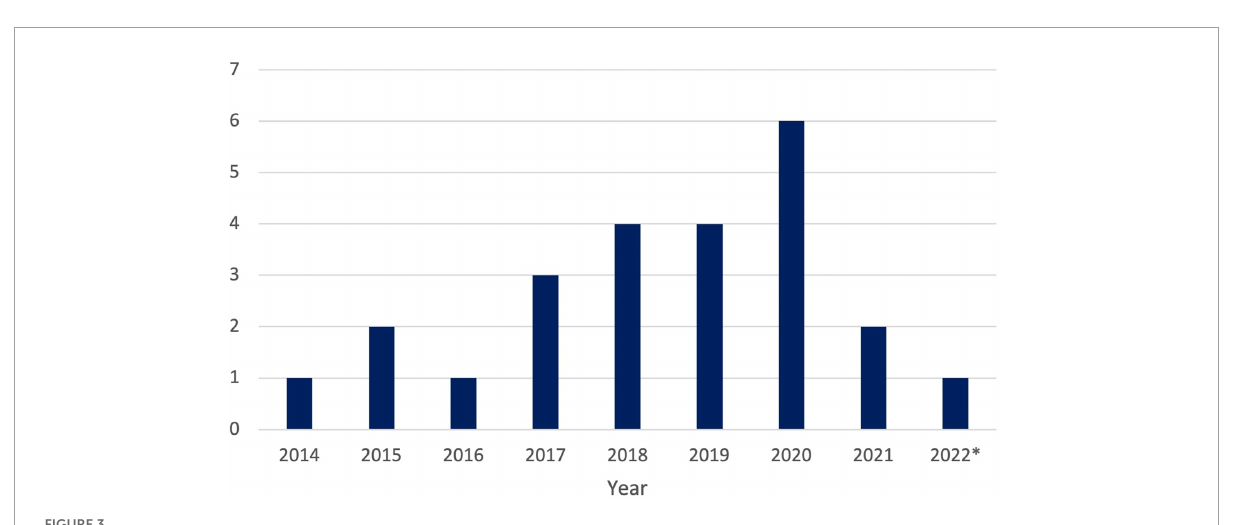
FIGURE3 Number of papers by publication year. *Before March